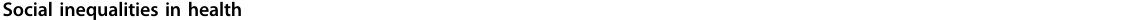
Table 3 Key findings from Phase II Social inequalities in health (cid:129) There is a large health divide between social groups. The category of SC/ST (targeted by positive discrimination) is heterogeneous: one ST group, the Paniyas, are particularly disadvantaged. The divide between ST and non-ST populations persists even after controlling for poverty and education. These results illustrate that STs ’ vulnerability in the social structure goes well beyond material deprivation [18]. Health of Paniyas ■ Paniyas have high levels of health needs; their prevalences of underweight, anaemia, and goitre are 60%, 15%, and 11% respectively [18]. Inequalities in health exist across generations. Young adults are particularly disadvantaged with respect to hypertension. Paniyas reported that they are caught in multiple “ vulnerability traps ” , that is, they view their situation as vicious cycles from which it is difficult to break away [13;19]. ■ Alcohol is viewed as a problem among the Paniyas who reported that: 1) its consumption is increasing, notably among younger men; 2) it is easily available in licensed shops and is produced illicitly in some colonies; 3) it is used to attract Paniyas for work by some local employers; and 4) it is associated with a range of social and economic consequences that are rooted in historical oppression and social discrimination [16]. Population health interventions ■ Women office bearers of SNEHA have proven themselves capable of decisionmaking and tackling challenges proactively (see, for instance, the change of insurance company). They have developed their negotiating power (see the negotiation with the insurance company that took over the scheme), have gained a profound knowledge of health insurance and of inclusion issues (see the revision of eligibility criteria for enrolling in the CBHI), have shown leadership and have overcome political pressure (SNEHA at present is not ruled by its governing body but by informal leadership). Today the CBHI is still functional with about 1,000